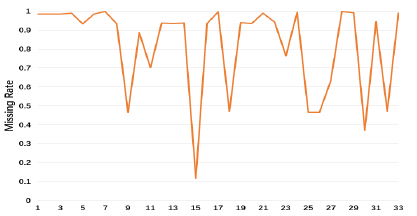
Figure 5. Missing rate of 33 variables in PhysioNet. x -axis, missing rate, y -axis, variable id in PhysioNet. maximum missing rate: 0.9985, minimum missing rate: 0.1161, average missing rate: 0.8193.